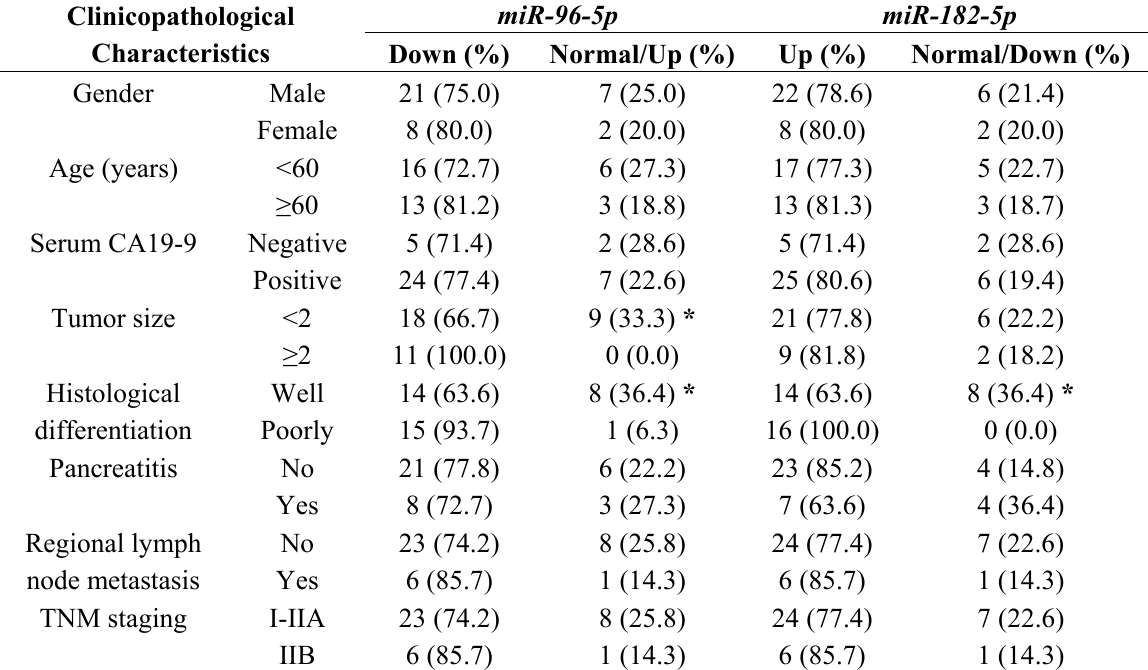
Table 1. Correlations between miR-96-5p , miR-182-5p , and various clinicopathological characteristics of pancreatic cancer (PC)